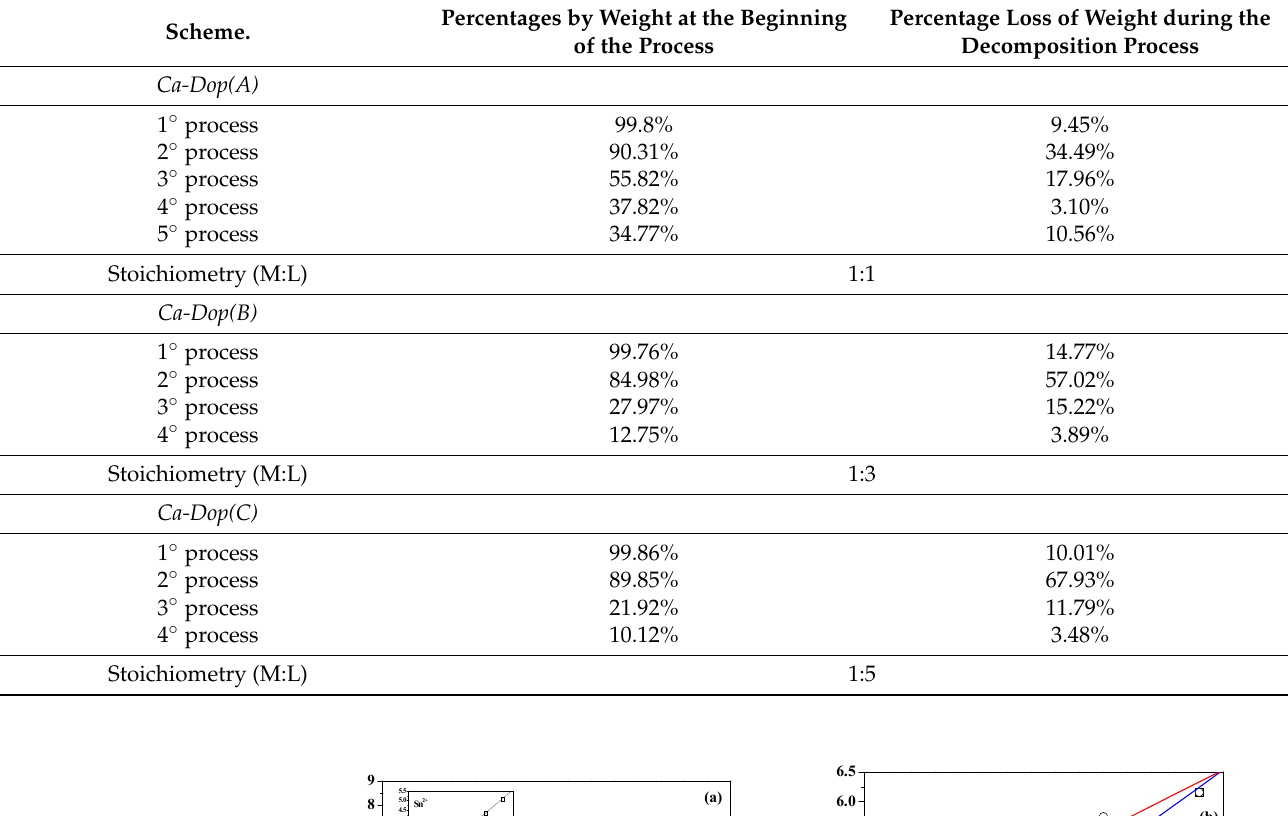
Table 15. Thermal decomposition steps for the Ca 2+ /Dop − precipitates.